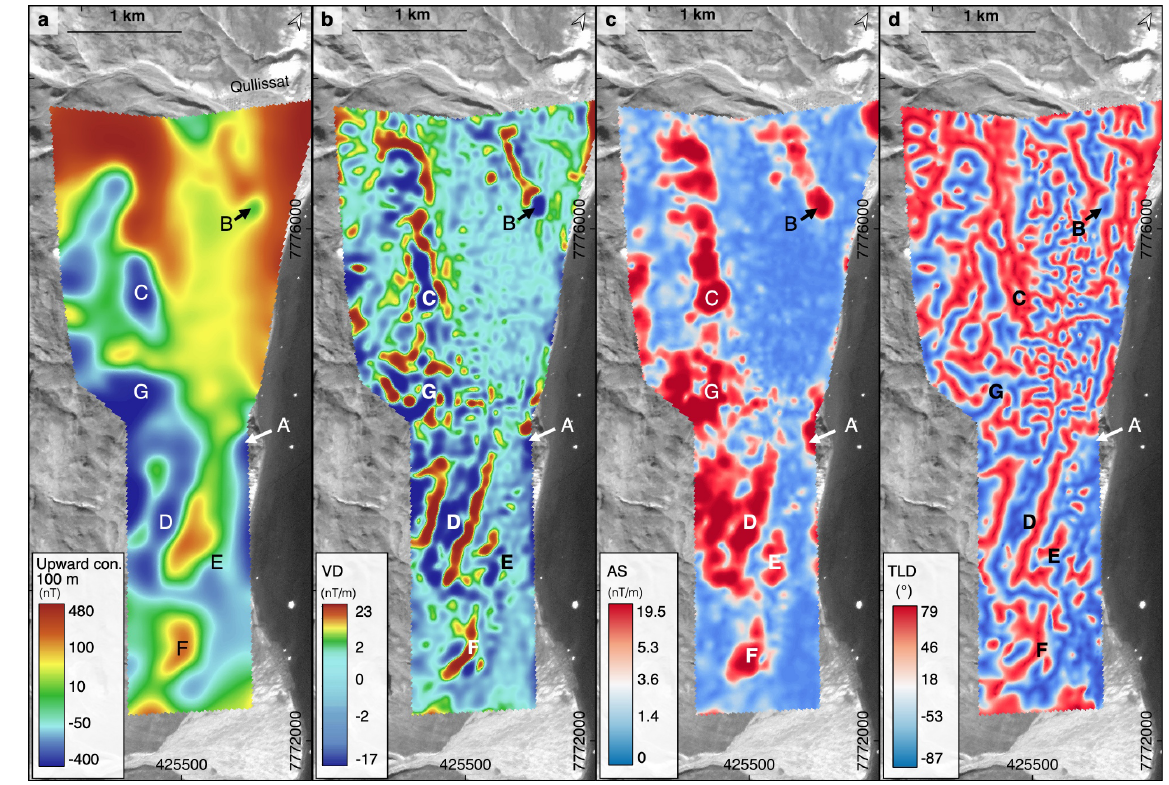
Figure 4. Magnetic filter maps obtained from the residual magnetic anomaly of the UAS-based magnetic data in the Qullissat area. (a) The residual magnetic anomaly is upward-continued (upward con.) to 100m (UP100) to enhance anomalies at larger depths. (b) The first vertical derivative (VD) is presented to enhance short-wavelength near-surface features. (c) The analytic signal (AS) amplitude is presented to highlight areas with increased magnetization, independent of the magnetization direction. (d) The tilt derivative (TLD) map highlights both surficial and deeper structural